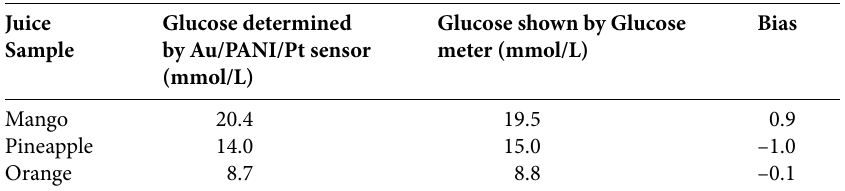
Figure 12. Chronoamperometric response of Au/PANI/Pt electrode in determination of glucose in (a) mango juice, (b) pineapple juice, and (c) or- ange juice. Std1:1 mM, Std2: 2 mM, Std3: 3 mM, Std4: 4 mM glucose. Insert shows the respective standard addition graph. Table 2. Concentration of glucose recorded in various boxed juice